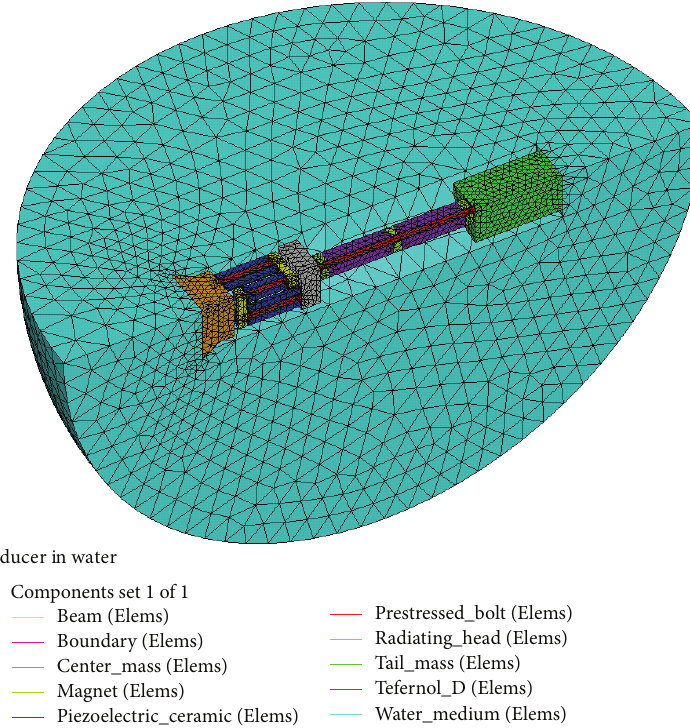
Figure 5: Finite element model of the Hybrid transducer in water (including 20701 nodes and 29496